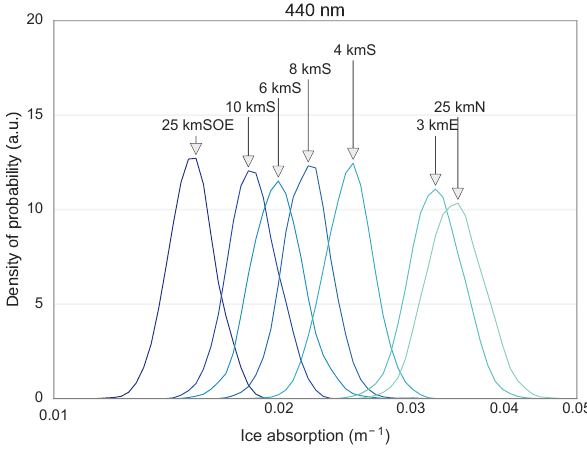
Figure 8. Posterior of ice absorption at 440nm independently esti- mated on different sites by the BAY